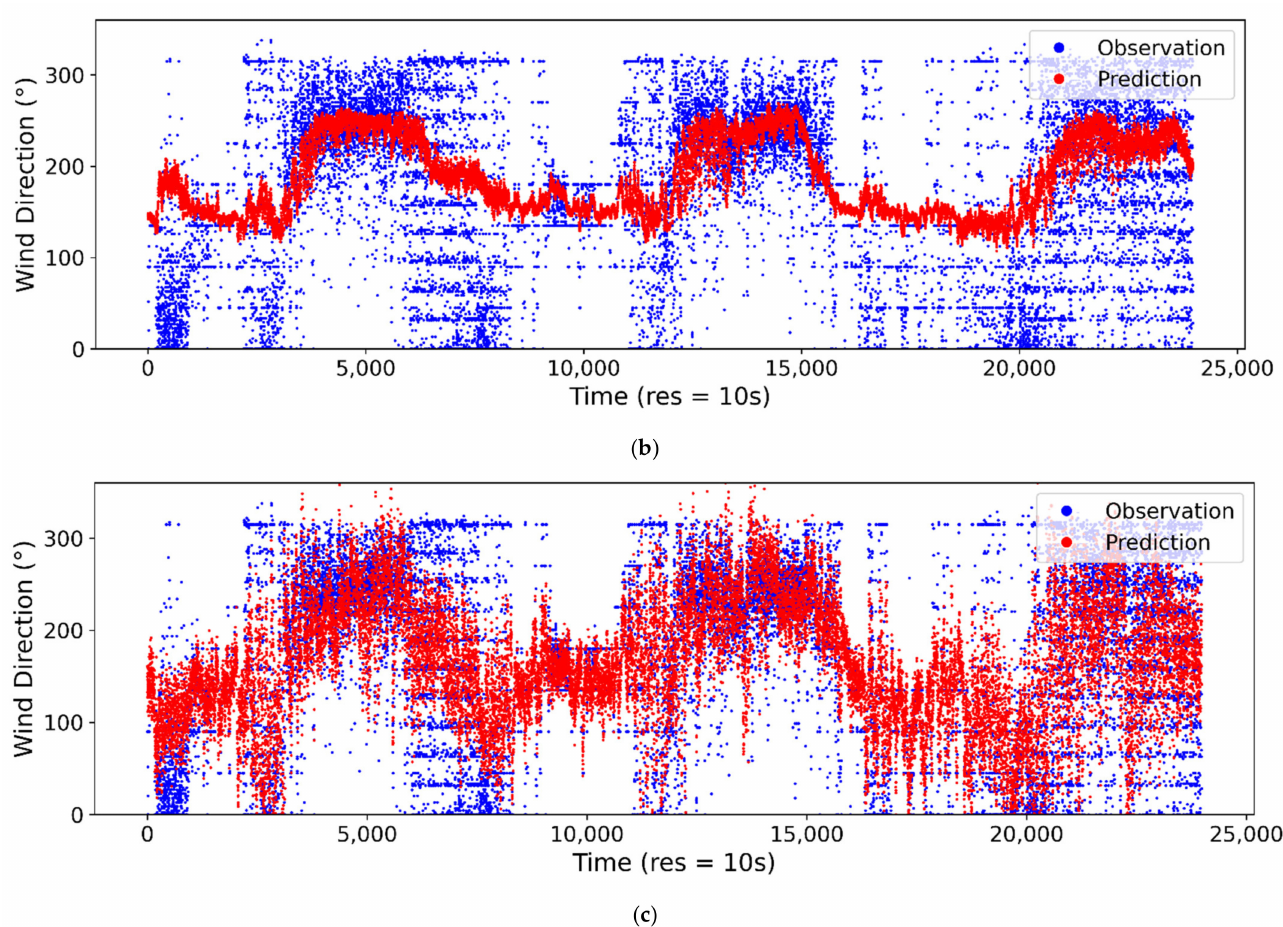
Figure 7. Comparison of predicted/estimated and observed wind direction at 10-s sampling interval for ( a ) ANN, ( b ) SVM and ( c )